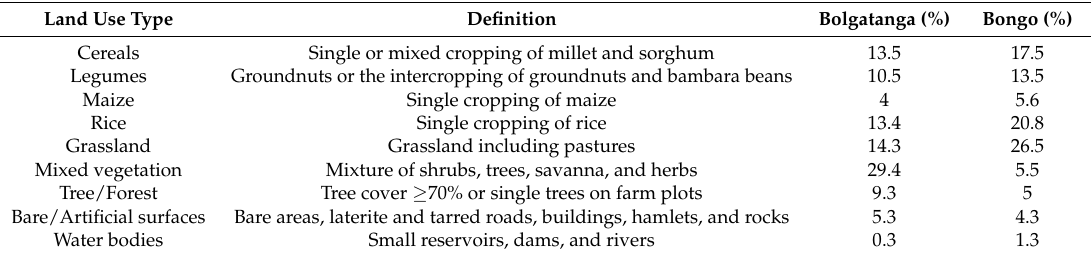
Table 1. Definition of land use types for the wet season in the study area and the percentage of the area occupied by each land use type corresponding with the district land use map